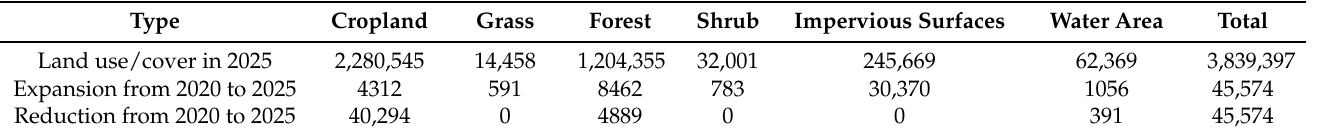
Table 7. Prediction results and analysis of land use/cover in